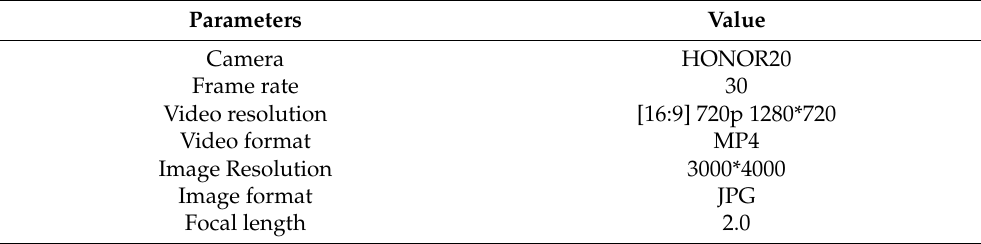
Table 1. Related parameters of database.